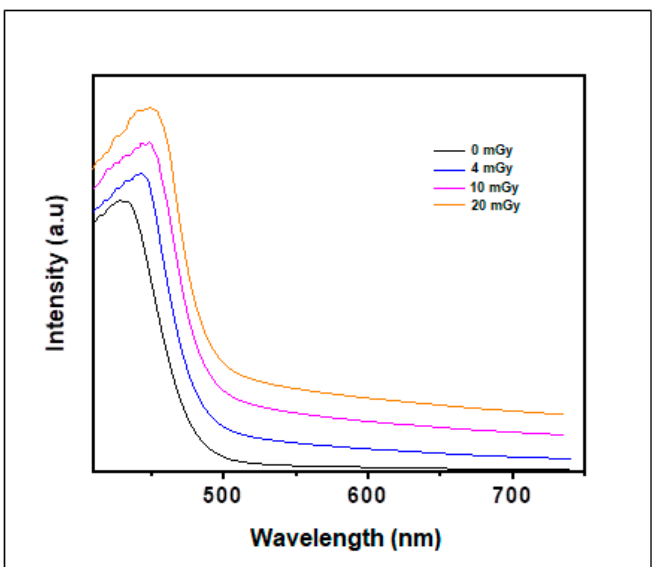
Figure 3. Absorbance spectra of PVA/NBT nanocomposite films before and after X-irradiation at varying doses.